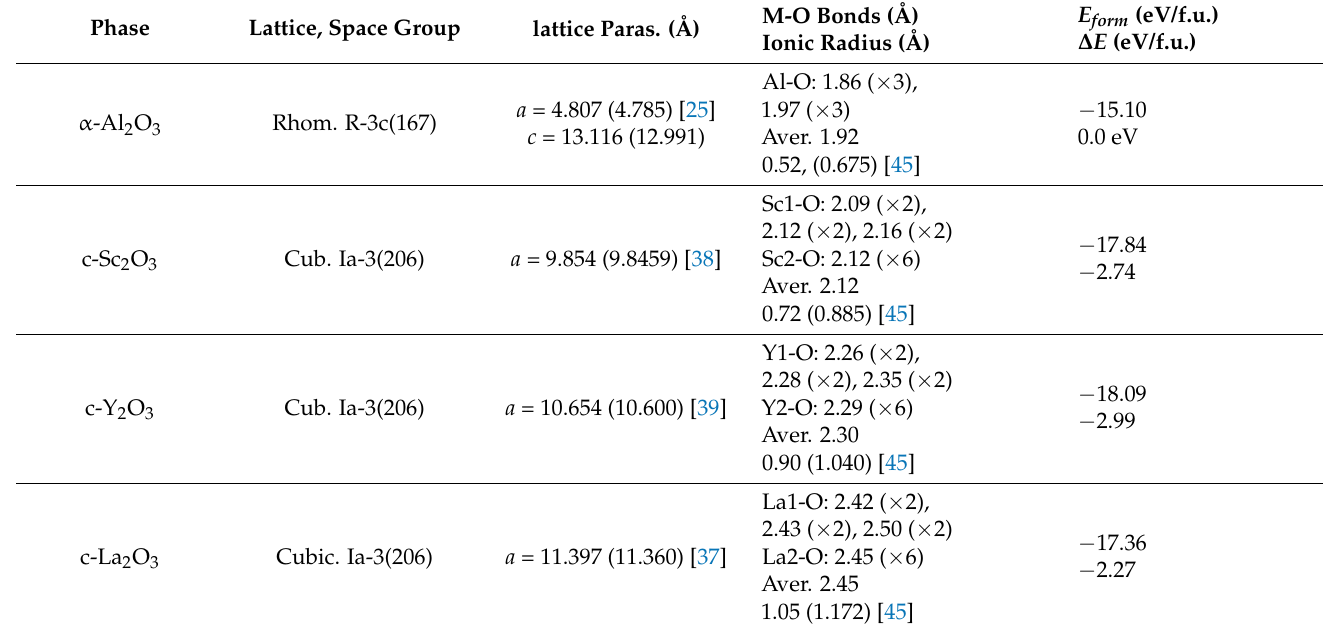
Table 2. Calculated results (lattice parameters, O-M interatomic distances and formation energies according to Equation (3)) for the ground M 2 O 3 compounds. Experimental data (in the parenthesis) available in the literature [25,37–39] are included for comparison. E form is the formation energy eV/f.u. (M 2 O 3 ) according to Equation (3), and ∆ E to Equation (5). The ionic radii are included (see the text). The effective crystal ionic radii in the literature [45] are included in parenthesis for